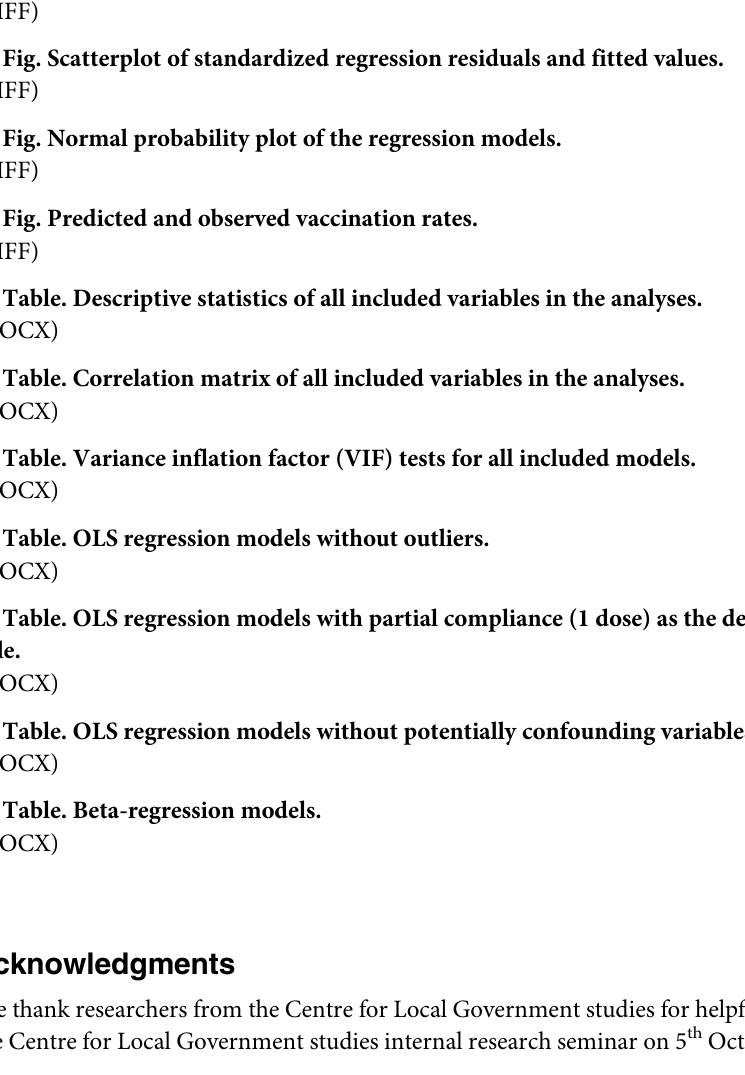
S2 Fig. Scatterplot matrix of all included variables in the analyses. (TIFF) S3 Fig. Scatterplot of standardized regression residuals and fitted values. (TIFF) S4 Fig. Normal probability plot of the regression models. (TIFF) S5 Fig. Predicted and observed vaccination rates. (TIFF) S1 Table. Descriptive statistics of all included variables in the analyses. (DOCX) S2 Table. Correlation matrix of all included variables in the analyses. (DOCX) S3 Table. Variance inflation factor (VIF) tests for all included models. (DOCX) S4 Table. OLS regression models without outliers. (DOCX) S5 Table. OLS regression models with partial compliance (1 dose) as the dependent vari- able. S6 Table. OLS regression models without potentially confounding variables. (DOCX) S7 Table. Beta-regression models.